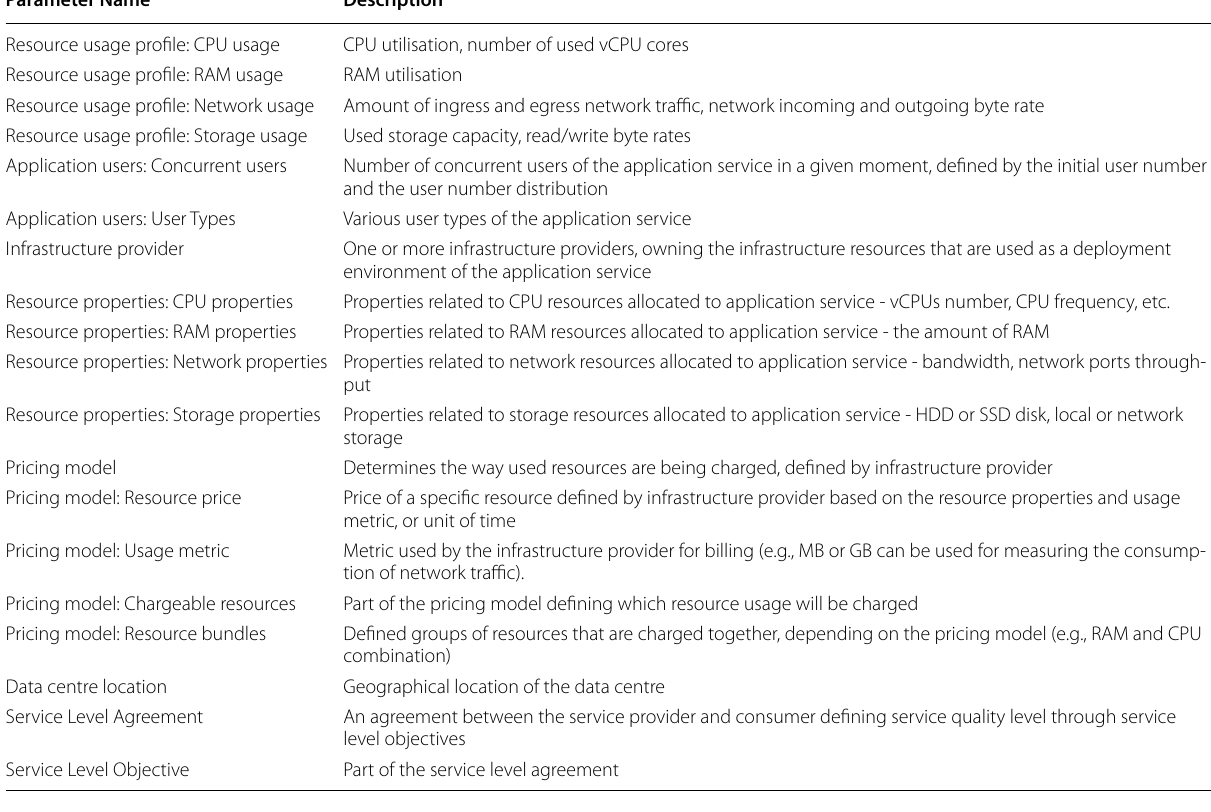
Table 1 Parameters of the cloud application context